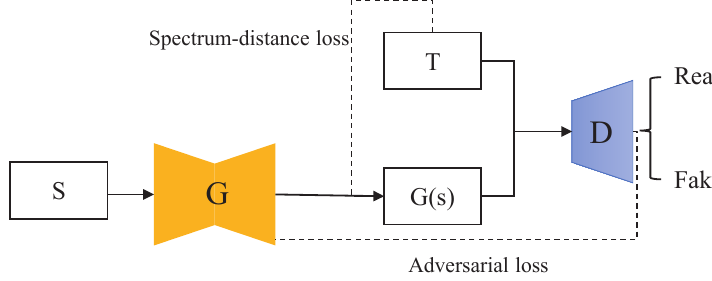
Figure 2. The structure of the GAN model in the BSEGAN-SI